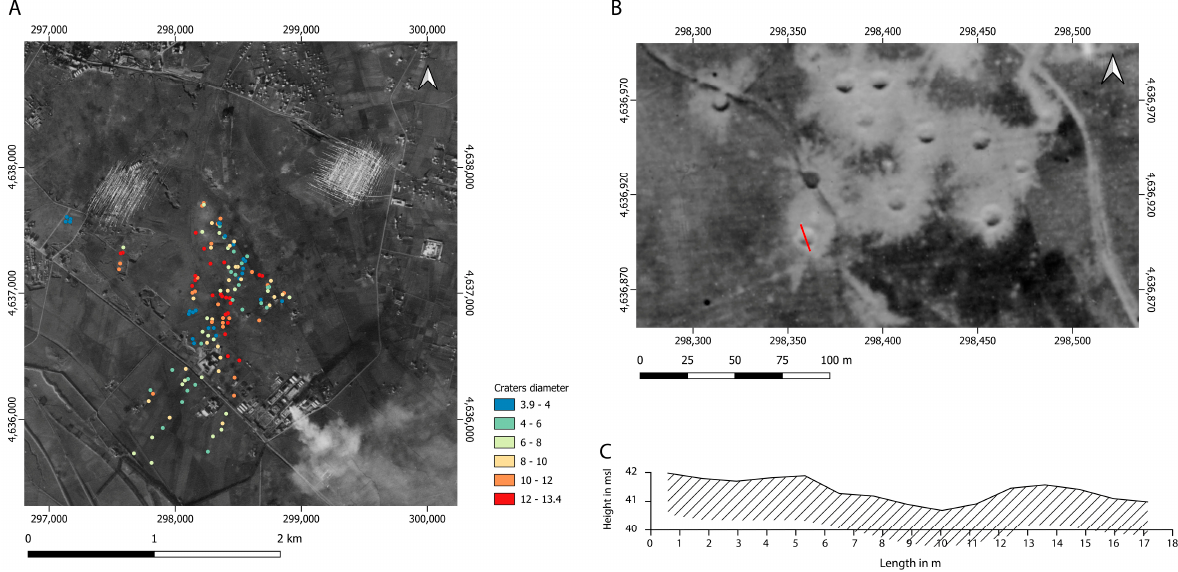
Figure 9. ( A ) Vectorization of the craters of impact and classification of the diameters of the craters, expressed in m; ( B ) detail of the orthophoto and position of the profile and ( C ) extraction of a profile from a historical 3D model. Photographs RAF_1944 from © ICCD-Aerofototeca Nazionale, Fondo RAF, flight 1944.